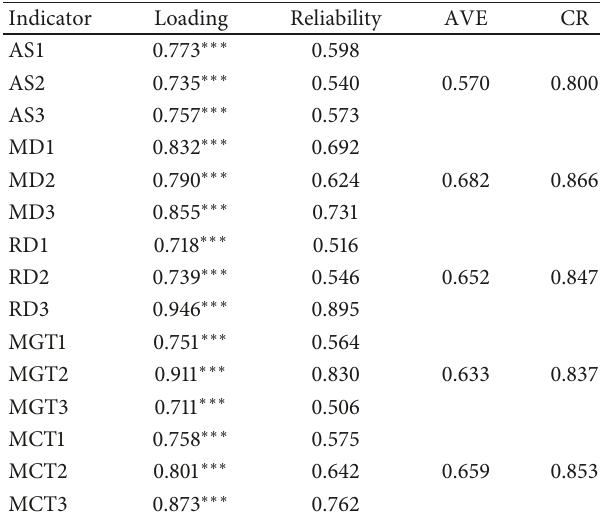
Table 3: Convergent